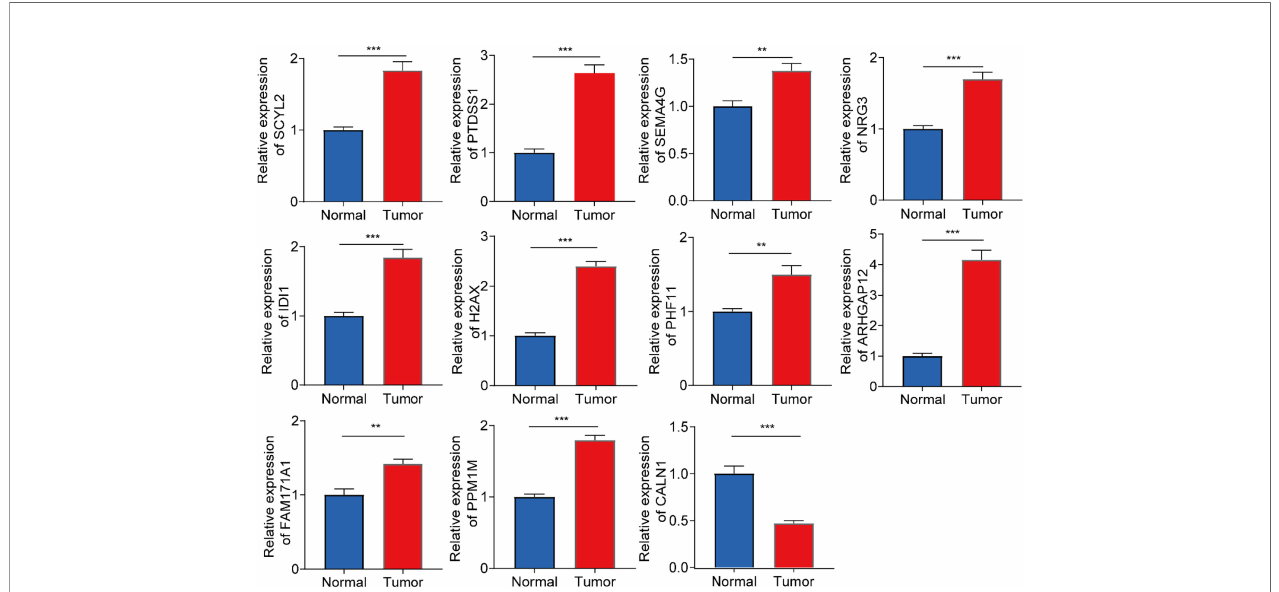
FIGURE 8 | RT-qPCR analysis on the expression levels of 11 genes in the prognostic model in 6 pairs of gliomas and their adjacent normal tissues. ***P<0.001, **P<0.01.